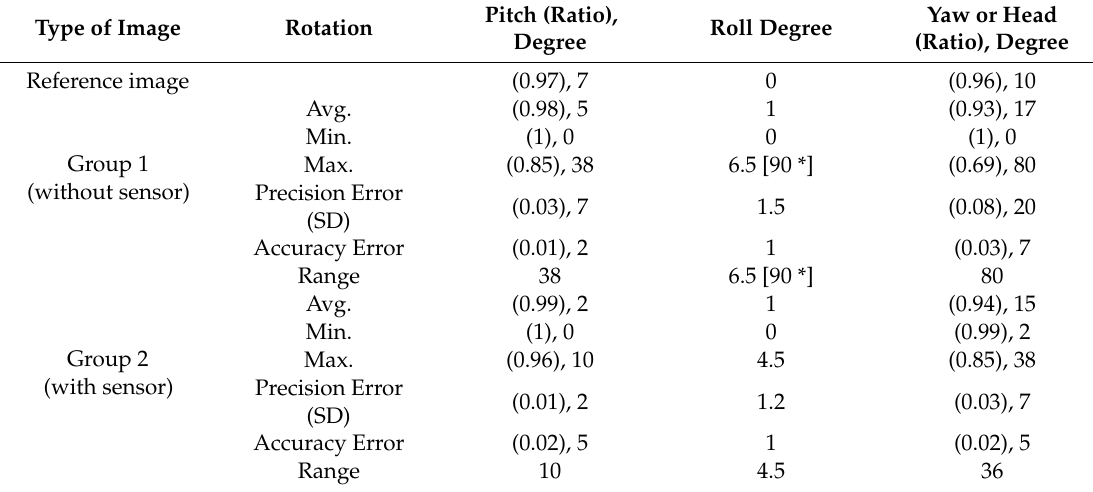
Yaw or Head Pitch (Ratio), Roll Degree (Ratio), Degree Degree